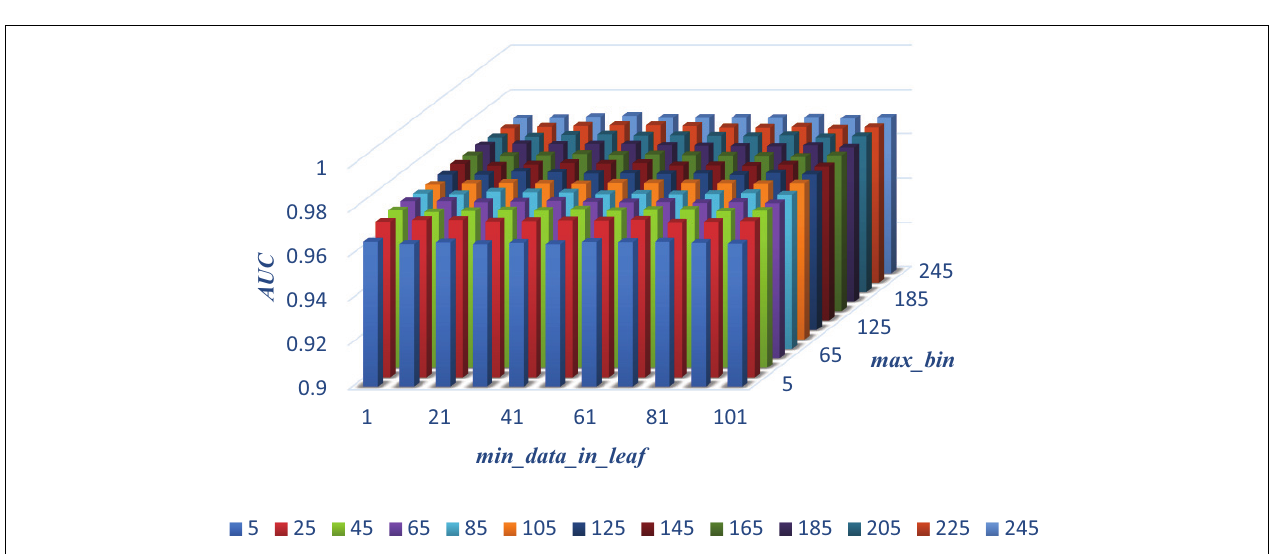
FIGURE 8 | The AUC value of different max_depth and num_leaves . Different color represents different values of max_depth. The X axis represents the different values of num_leaves , and the Y axis represents relevant AUCs.